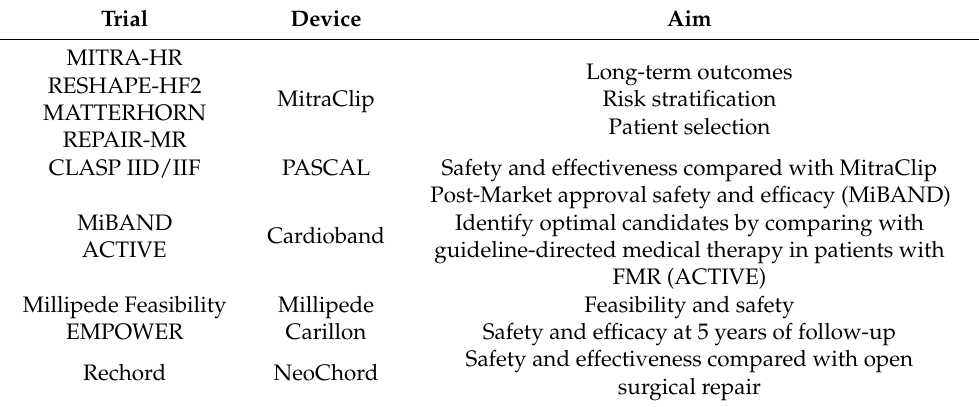
Table 2. Ongoing Trial of Transcatheter Mitral Valve Repair